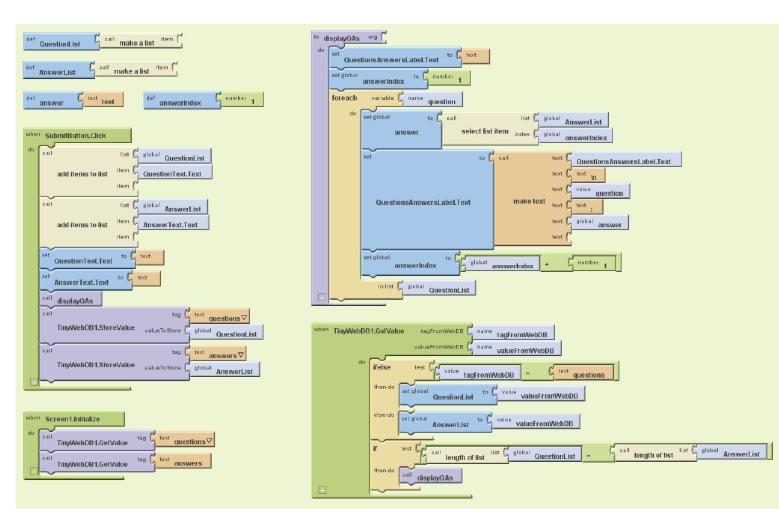
Fig. 8. Blocks screen of the making the quiz